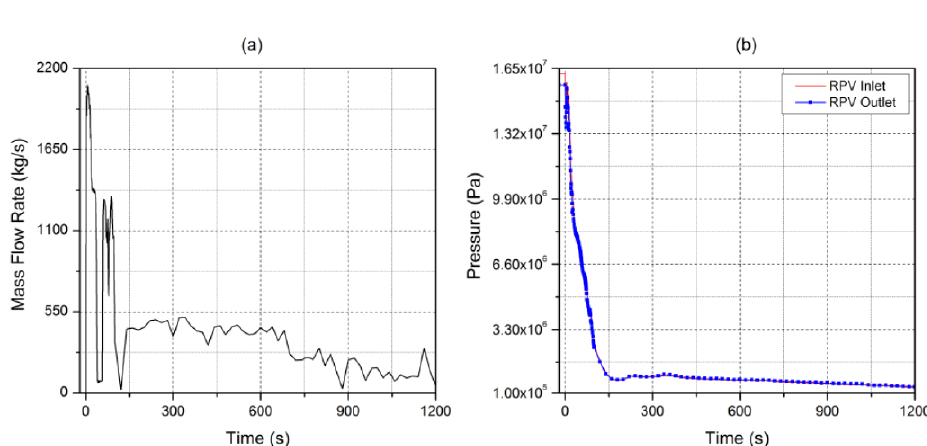
Fig. 6. Total break mass fl ow rate (a). Coolant pressure at inlet and outlet of the RPV (b).